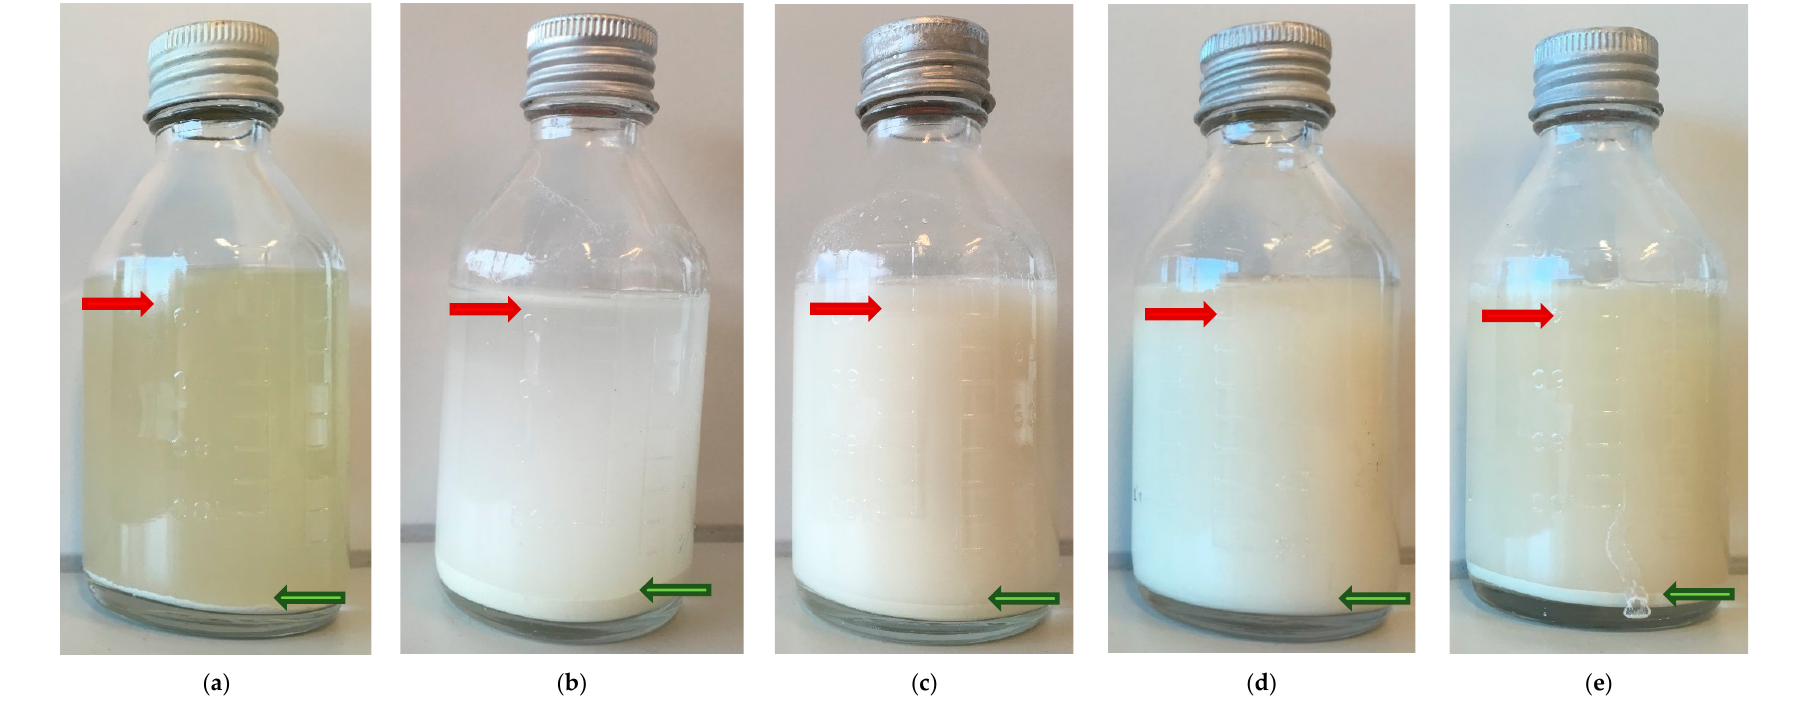
Figure 6. Bottles after 2 h of sedimentation. ( a ) Paper mill 1; ( b ) Landfill; ( c ) Cadaver; ( d ) Paper mill 2; ( e ) Paper mill 3. Red arrows indicate non-sedimented sulfur and green arrows sedimented sulfur.